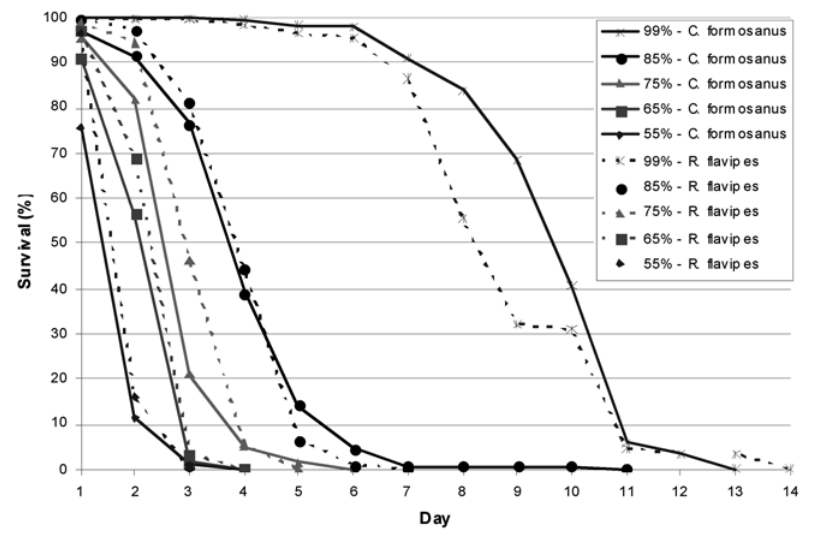
Fig. 4. Survival of small groups (18 workers + 2 soldiers) of C. formosanus and R. flavipes at 25 ° C and varying relative